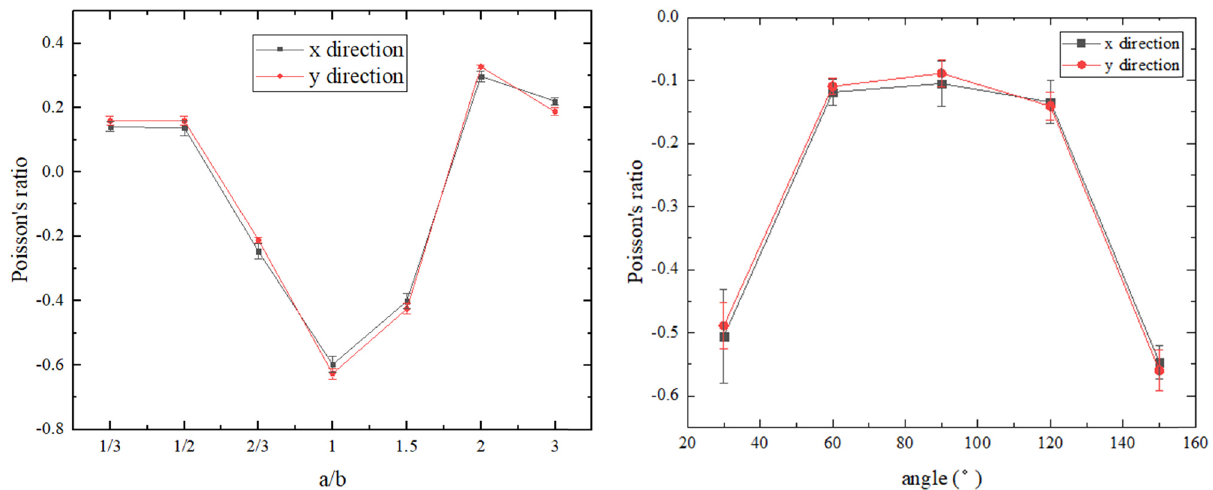
Figure 7: The change of Poisson ’ s ratio with the change of a/b value. Figure 8: Variation of Poisson ’ s ratio of PRGNs at di ff erent